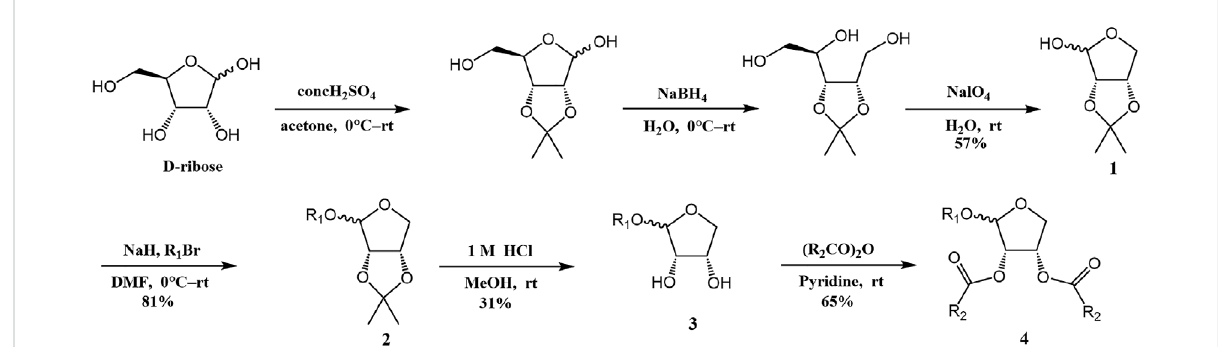
FIGURE 1 Synthesis of the derivatives of octadecanoic acid-3,4-tetrahydrofuran